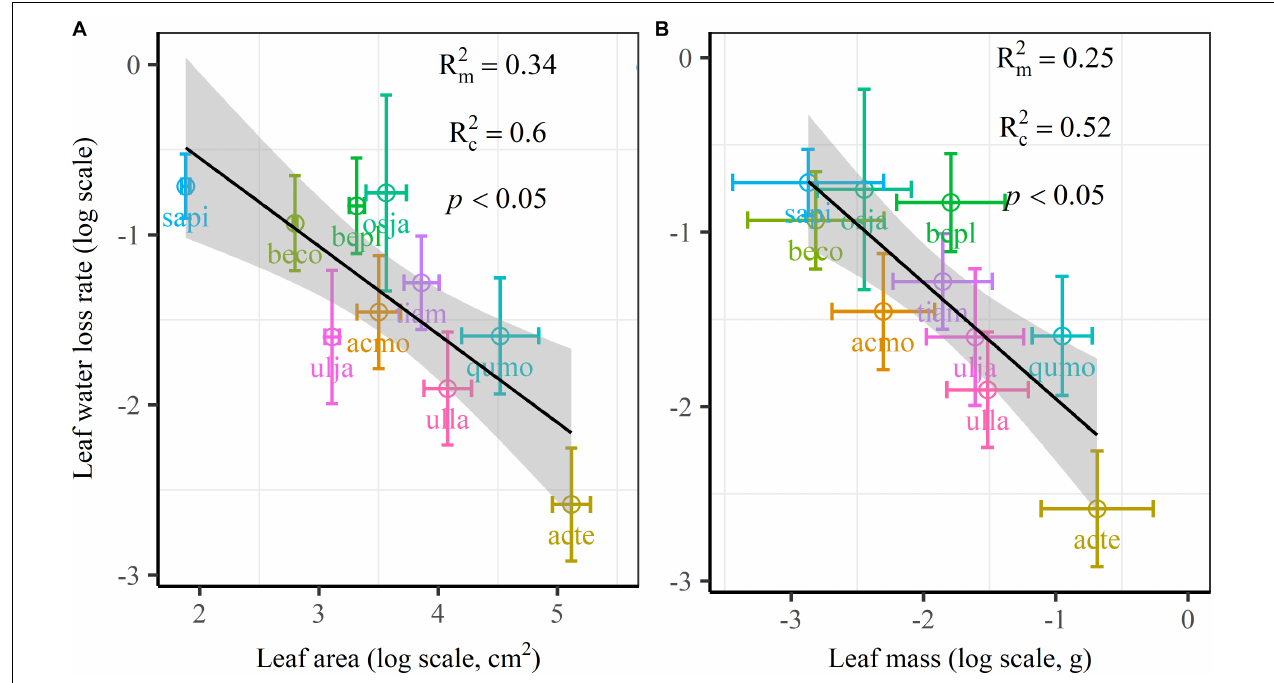
FIGURE 5 | Leaf water loss rate ( k ) in relation to individual leaf area (A) and individual leaf mass (B) of 10 simple-leaved tree species, analyzed using linear mixed models with individual leaf area or mass as the mixed factor and tree species as the random factor. Marginal R 2 (cid:0) R 2 m (cid:1) reflects the proportion of the variance explained by fixed factors and conditional R 2 (cid:0) R 2 c (cid:1) reflects the proportion of the variance explained by both fixed and random factors. Average value per tree species and its 0.1-fold standard error were given. Gray bands show 95% confidence intervals. The abbreviations of tree species were shown in Table 1